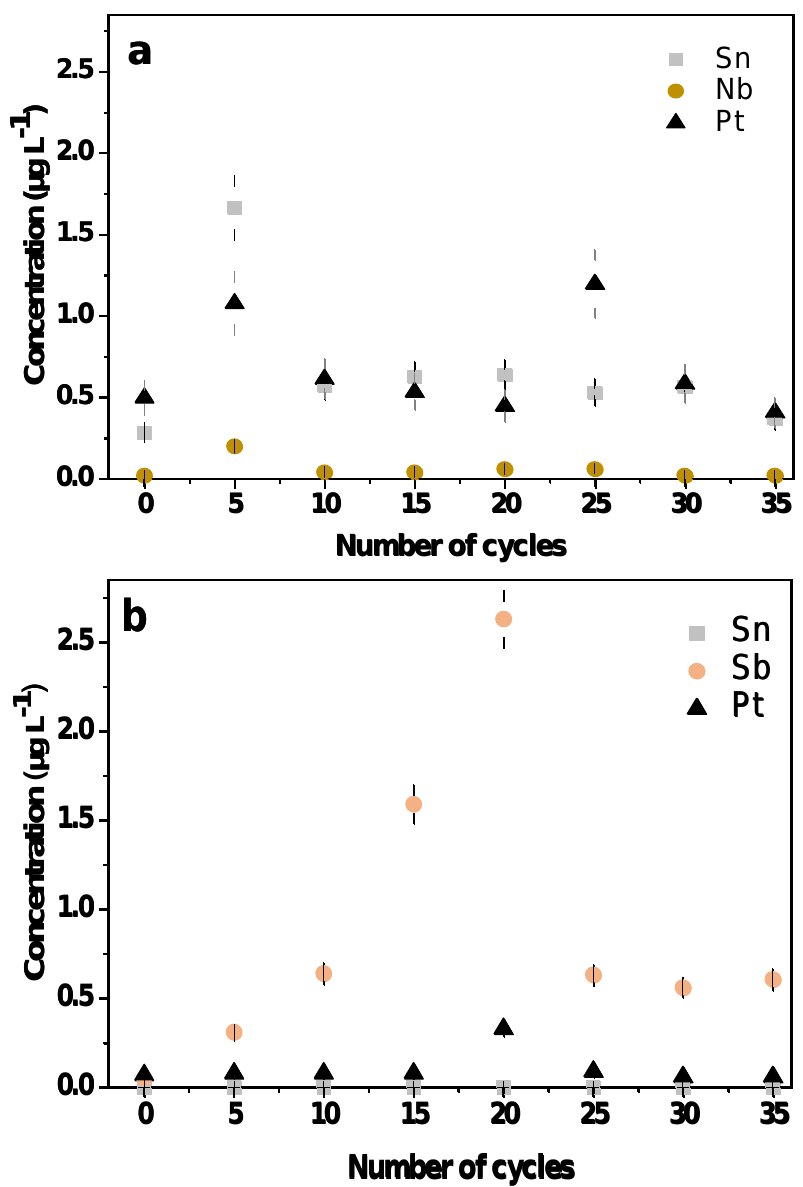
Figure 2. ICP–MS analysis of the selected elements (Sn, Nb, Sb, Pt) detected in the water recovered at the cathode side during start/stop cycling AST for Pt/NTO ( a ) and Pt/ATO-based MEAs ( b ).